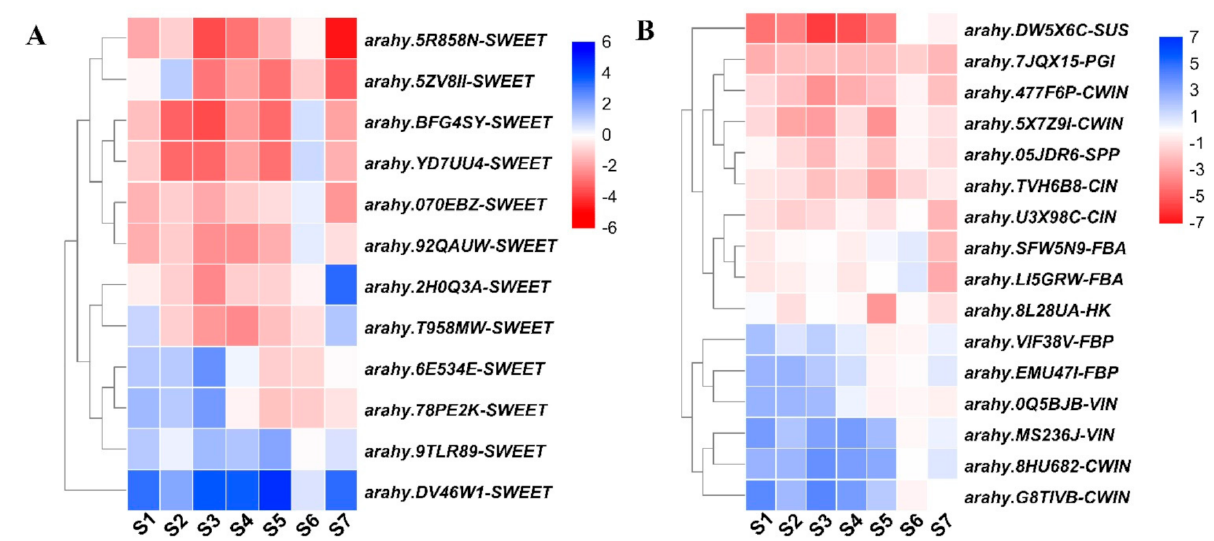
Figure 5. Expression comparison of genes related to sucrose metabolism in two varieties. The red and blue color indicate up-regulation and down-regulation in ICG 12625, respectively. ( A ) The heatmap showing the log2FC of 12 SWEET genes ( B ) The heatmap showing the log2FC of 16 enzyme